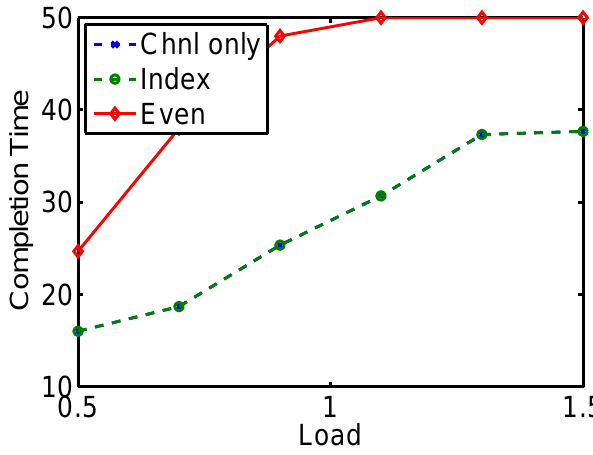
Figure 11. Job Completion Time when Index Policy Objective is Minimizing Average